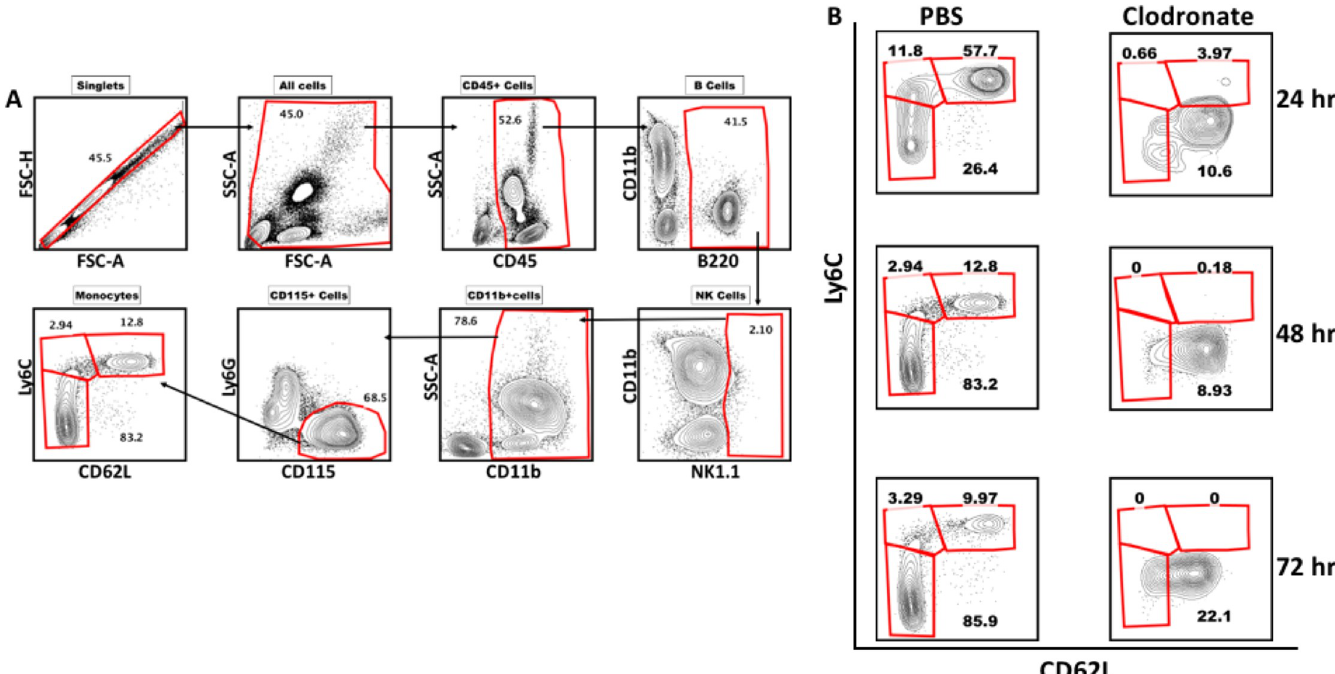
Fig 1. Confirmation of clodronate-induced monocyte depletion. A) Gating strategy for blood monocytes. B) Time line showing clodronate-induced monocyte depletion in mice from 24hrs to 72hrs after a single injection of clodronate as compared to sham-depleted (PBS) controls.